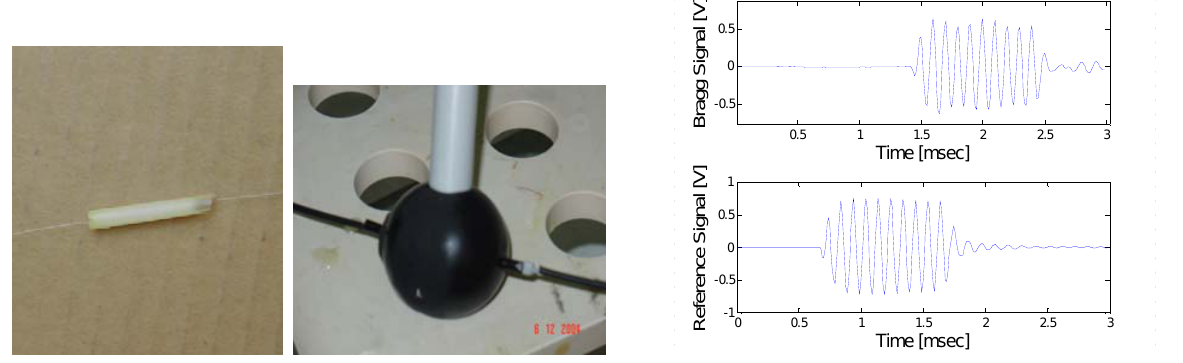
Figure 2. On the left: photographs of the tested hydrophones and, on the right, typical temporal response of the white coated FBG under test (upper) and of the reference hydrophone PZT (lower) to a sound pressure pulse of 2 kPa at the frequency of 10 kHz.